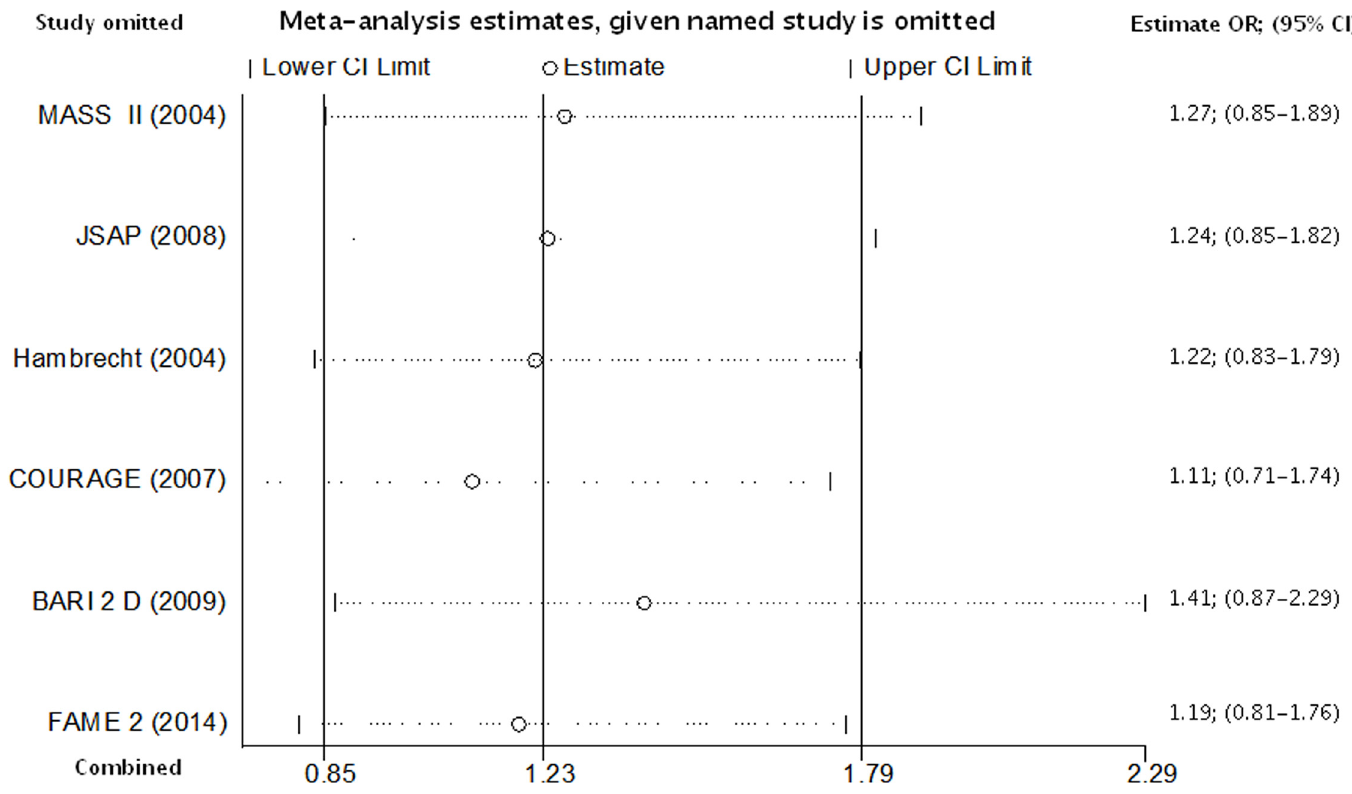
Fig 3. Risk of stroke in patients with PCI based strategy vs. patients with OMT based strategy. OR estimates given named study is omitted. Abbreviations: CI = confidence intervals OR = odds ratio.